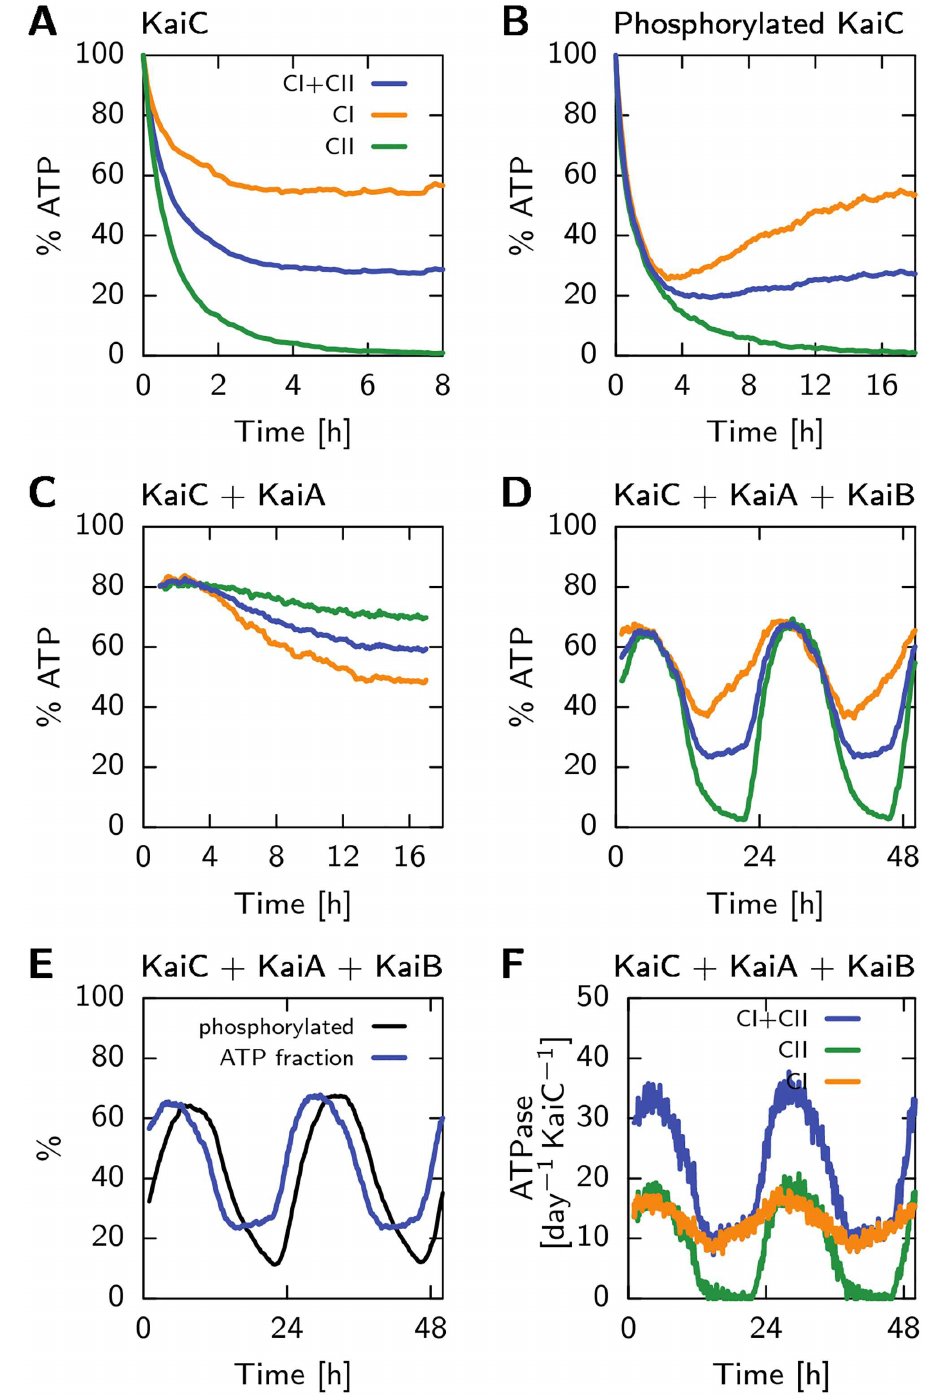
Fig 9. Model correctly predicts the ATP fractions in KaiC nucleotide binding pockets and the phase difference between this fraction and the phosphorylation level. Figures A-D show the fraction ATP/(ATP +ADP) in the nucleotide bindingpockets of the CI domain(orange),the CII domain (green)and their sum (blue), in a 100% ATP solution,for different scenarios:KaiC initiallyunphosphorylated, no KaiA and KaiB present (A), KaiC initiallyphosphorylated, no KaiA and KaiB (B), initiallyunphosphorylated KaiC + KaiA (C) and KaiC + KaiA + KaiB (D). (A) The ATP levels drop monotonically due to the slow hydrolysisin both the CI and CII domain.(B) ATP fractions in dephosphorylatingKaiC shows a clear trough in the ATP fraction of